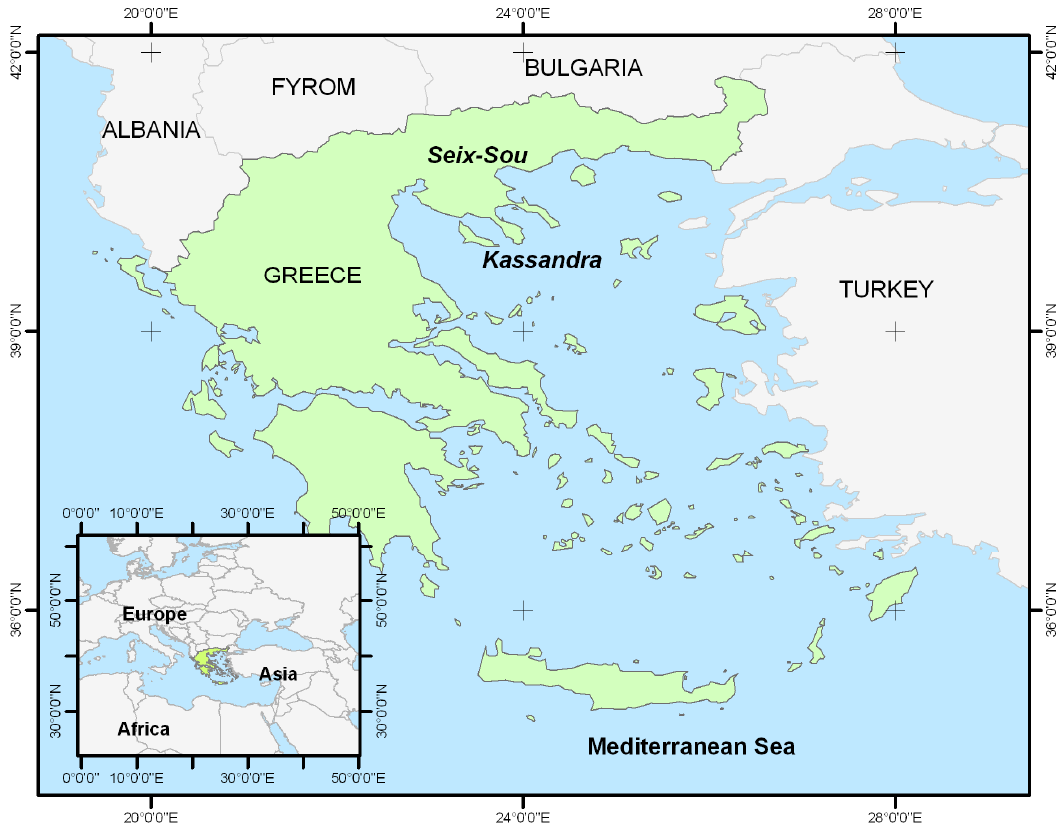
Figure 2. Location of the two study